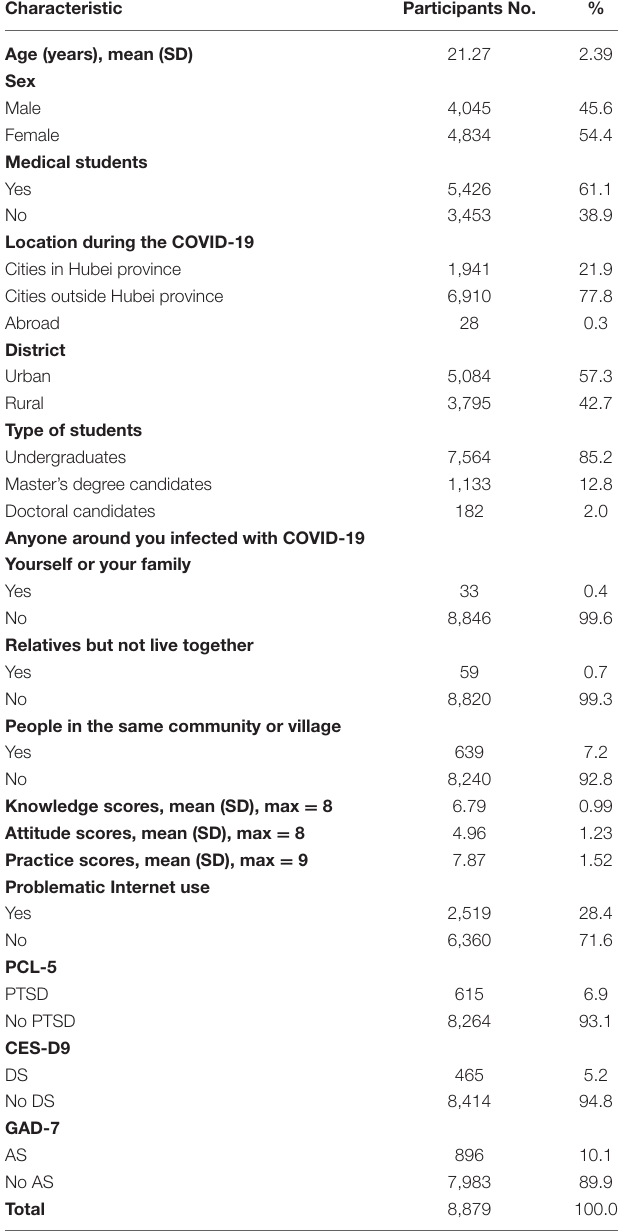
TABLE 1 | Characteristics of